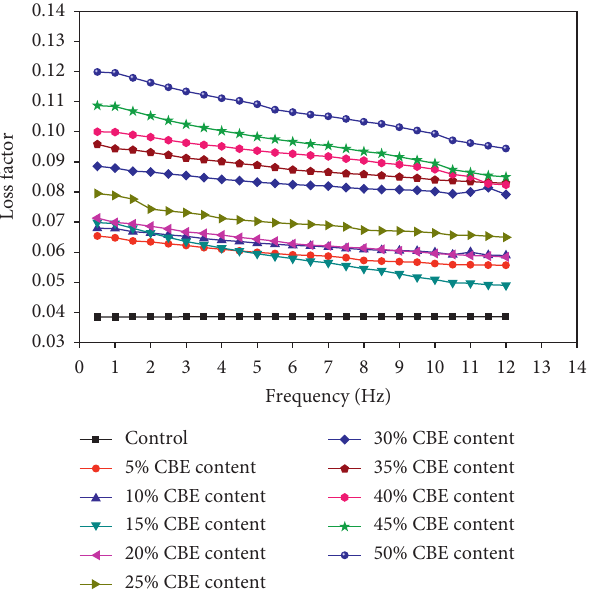
Figure 8: Influences of CBE content on the viscoelastic property.